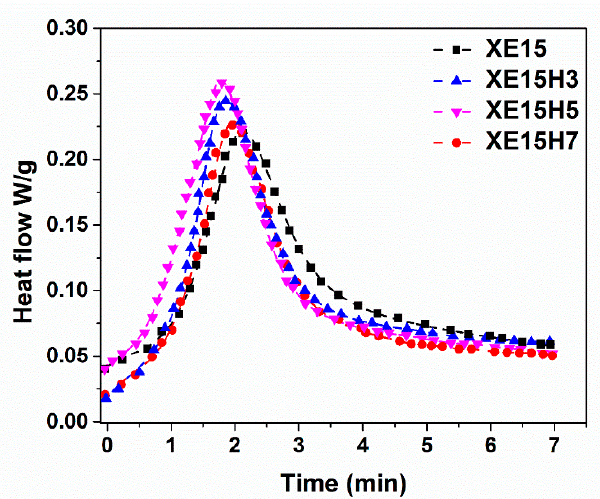
Figure 9. Typical isothermal differential scanning calorimetry (DSC) thermograms of various XNBR/epoxy/XHNT nanocomposites at 170 °C.